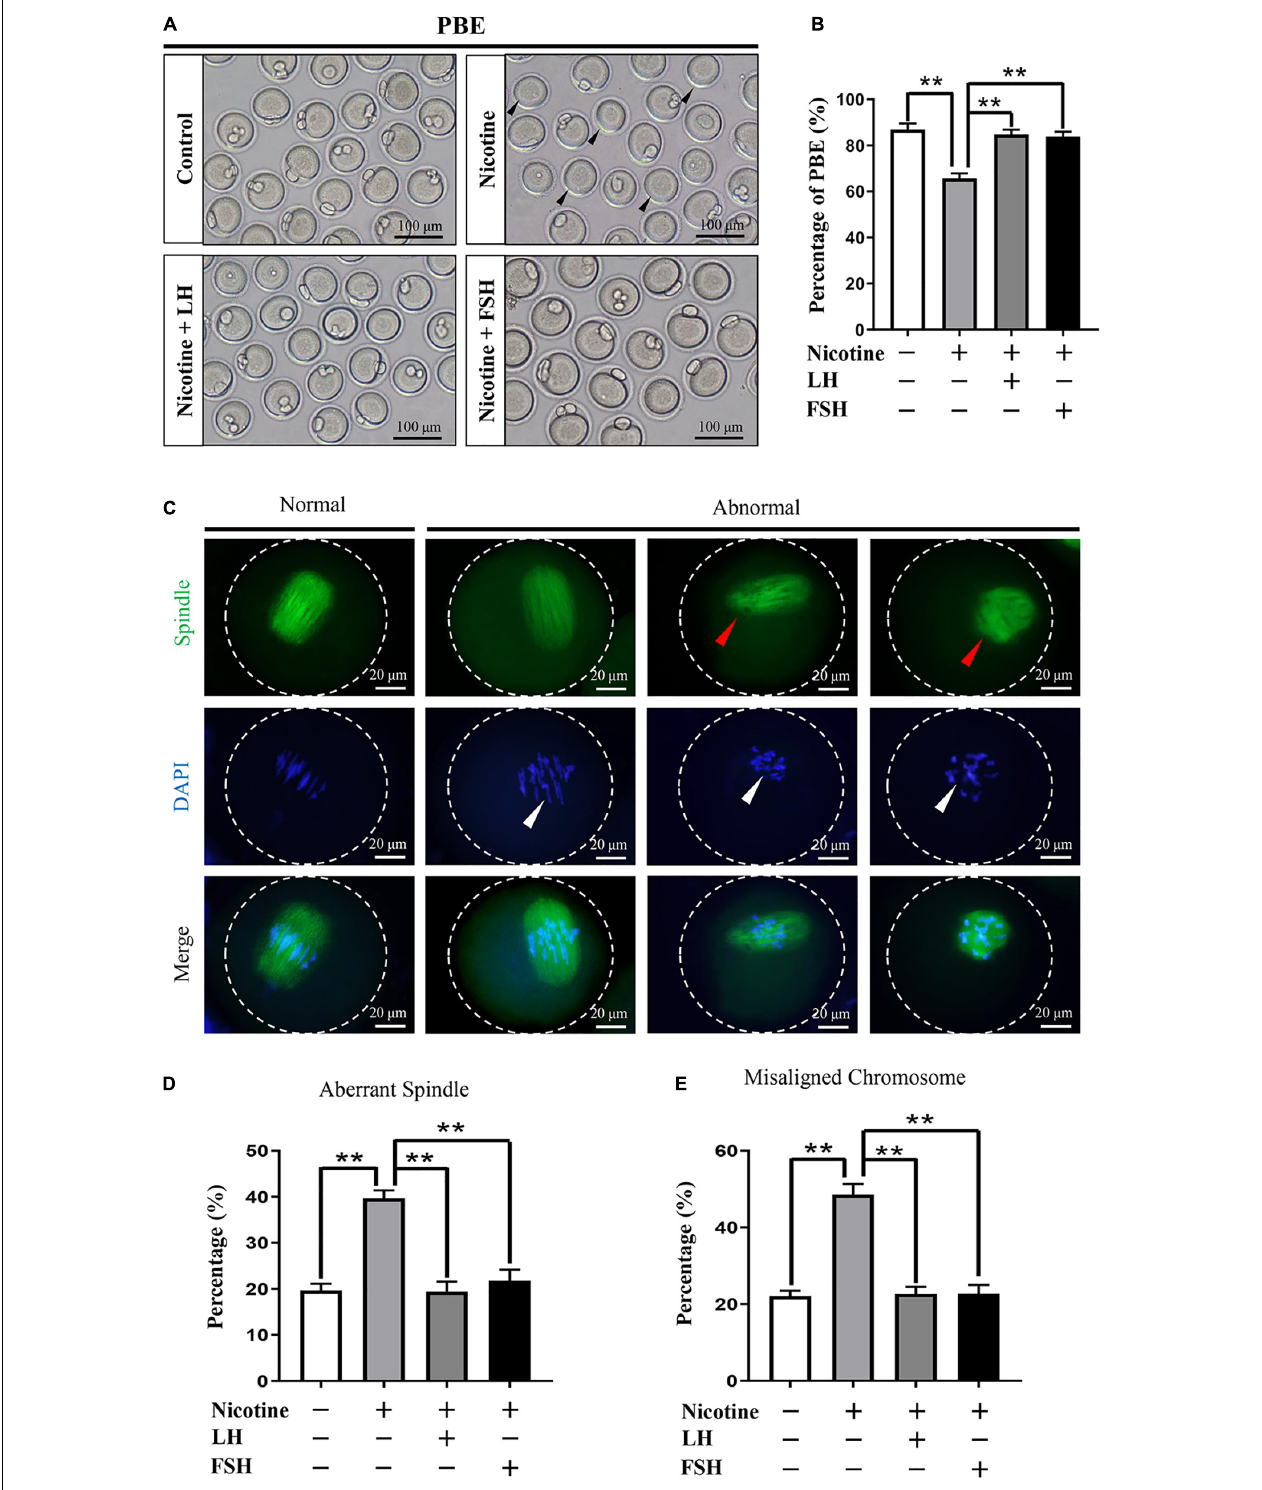
FIGURE 5 | Effects of LH or FSH on the meiotic maturation in nicotine-induced oocytes. (A) Representative images of oocytes with polar body extrusion (PBE; metaphase II of meiosis: MII) in each group. Scale bar, 100 µ m. The black arrows indicate abnormal PBE. (B) The rates of PBE in each group (control, n = 90; nicotine, n = 90; nicotine + LH, n = 90; nicotine + FSH, n = 90; and n = total number of oocytes from three replicate experiments). ( n = 16 newborn female pups in